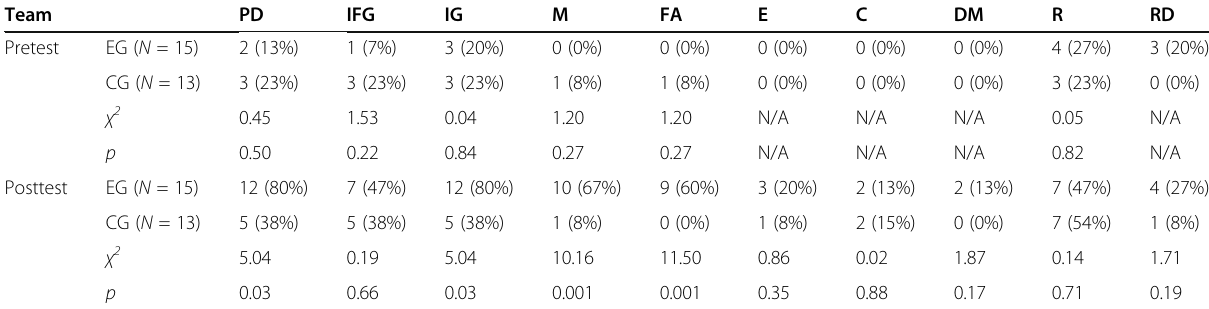
Table 4 Preservice technology teachers ’ performance: individual system concepts in engineering design thinking Team PD